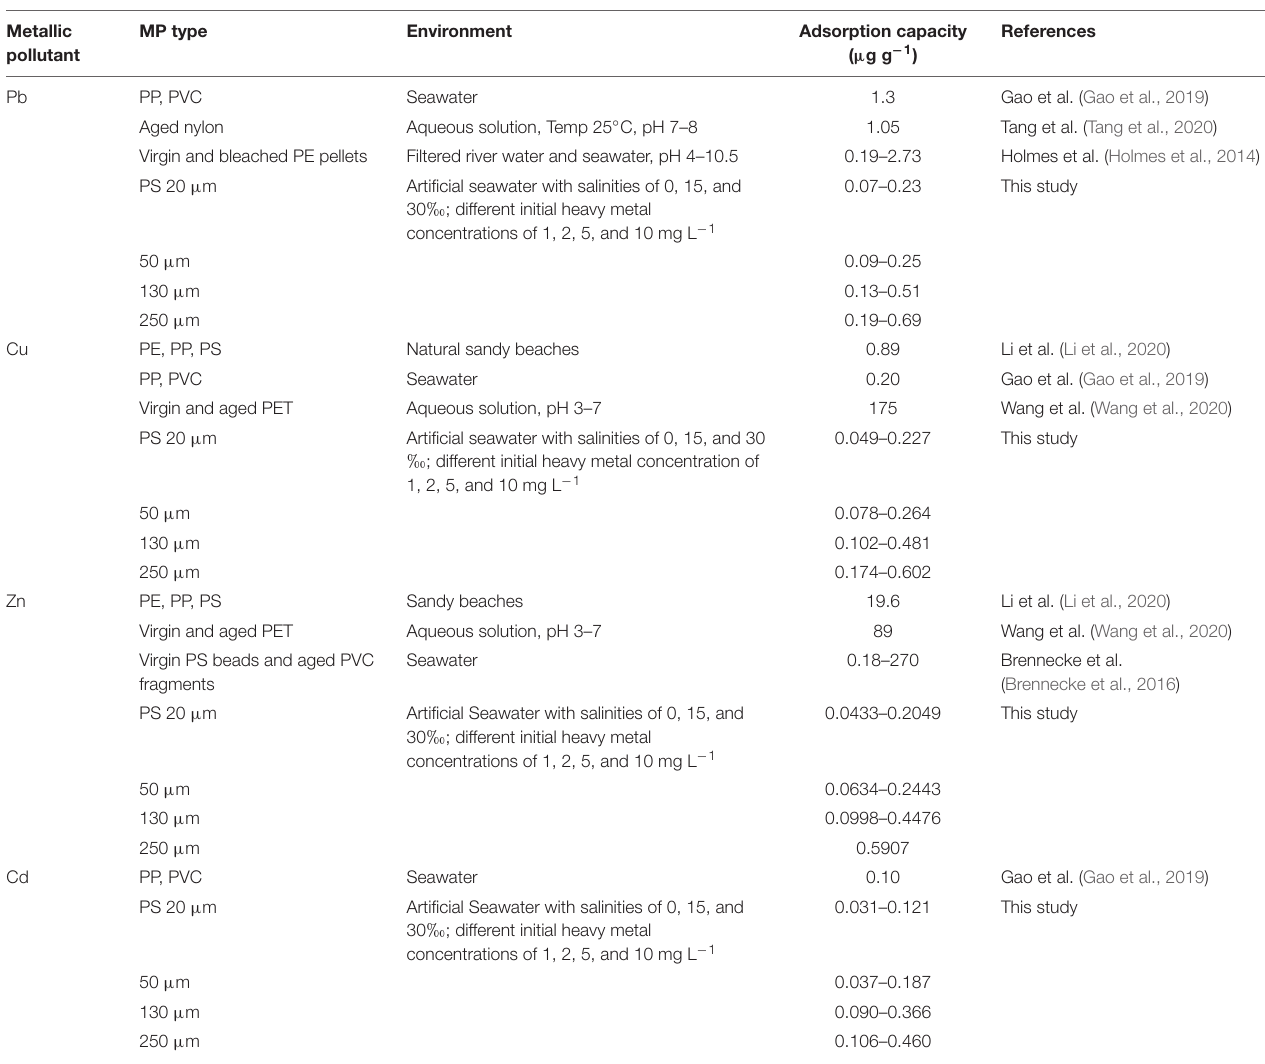
TABLE 1 | Various MPs and their sorbed metallic